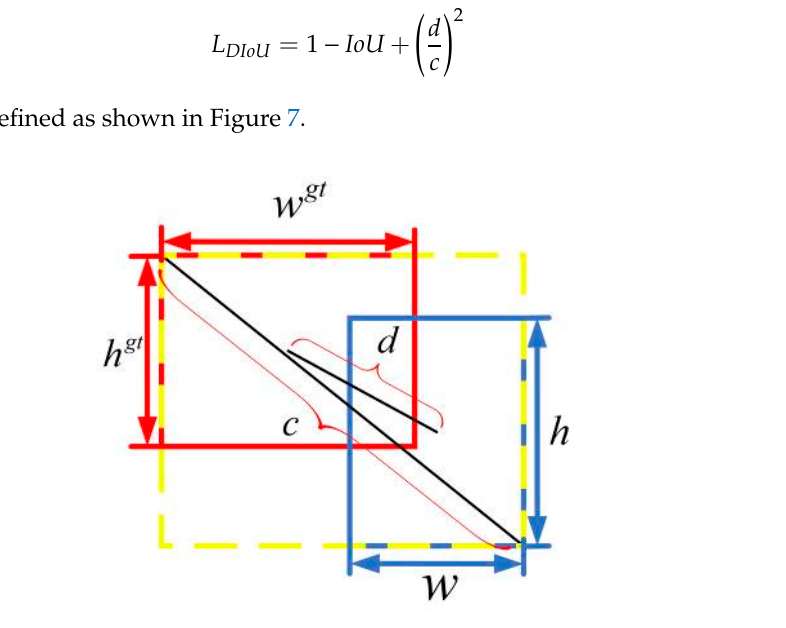
Figure 7. Schematic Diagram of Loss Function.